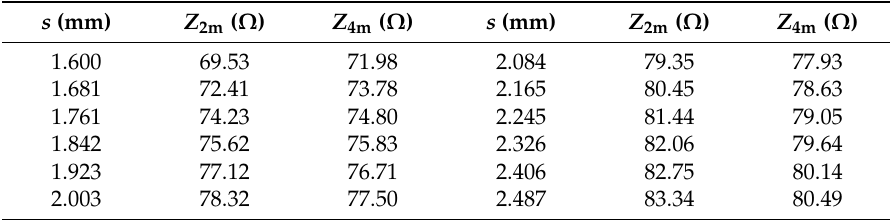
Table 3. The s and measured maximum Z at the 20 and 4 m